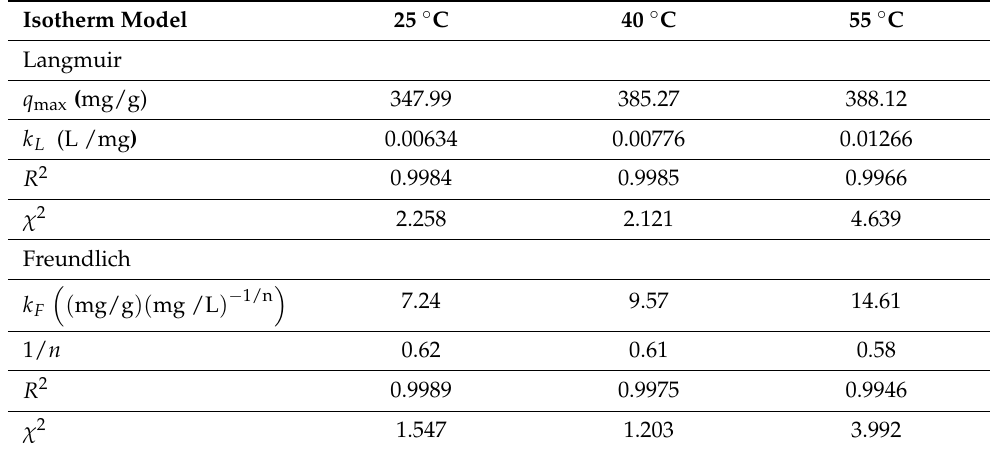
Table 2. Parameters of isotherms models for MB removal by the BE/SD–MNPs composite. Isotherm